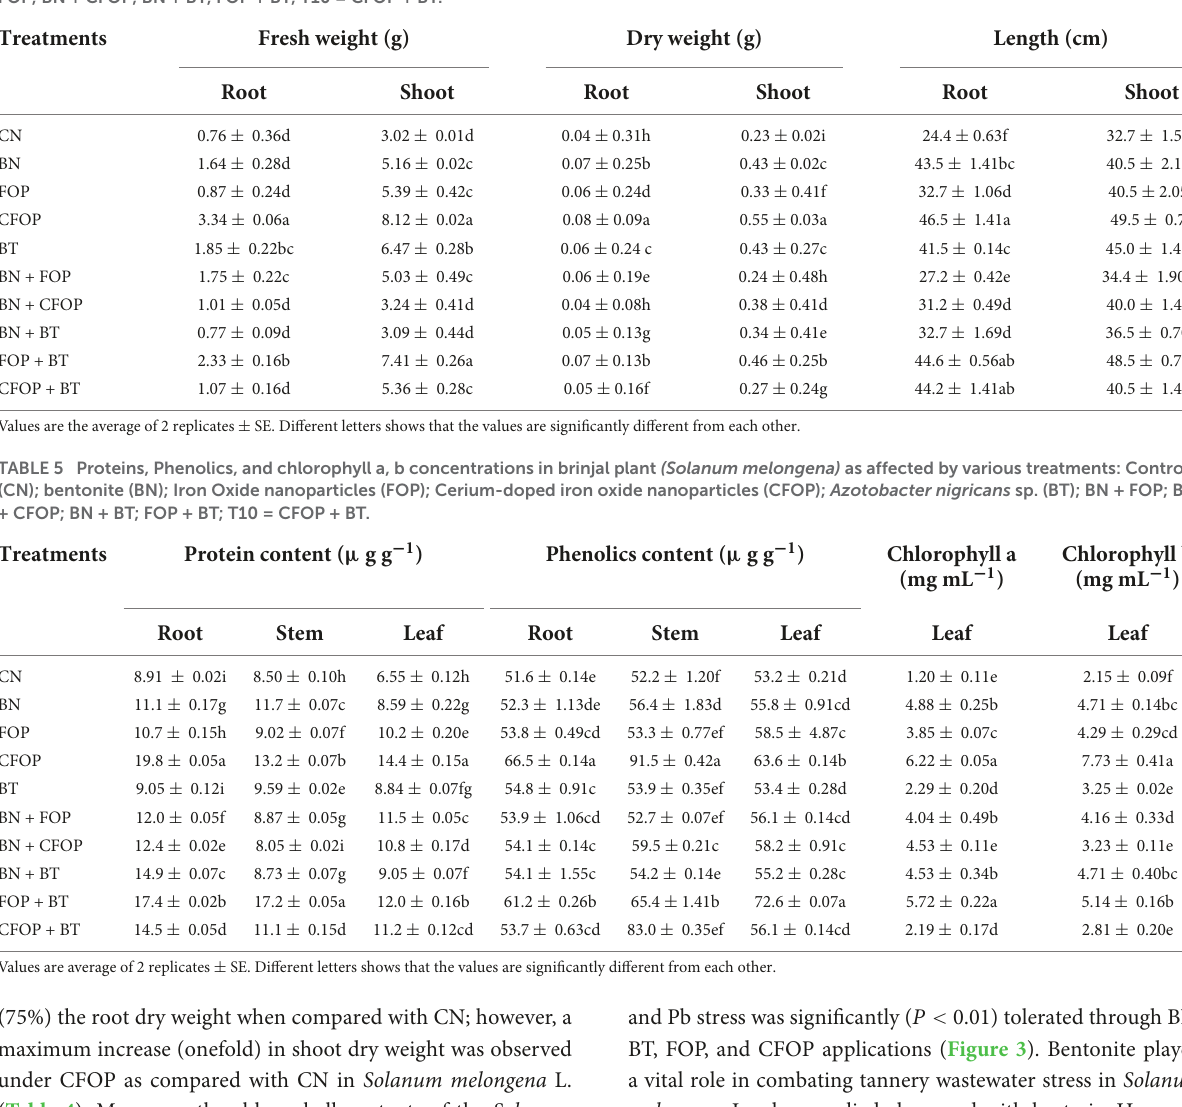
TABLE 4 Dry and fresh weight (g) and length (cm) of root and shoot of brinjal plant (Solanum melongena) as affected by various treatments: Control (CN); bentonite (BN); Iron Oxide nanoparticles (FOP); Cerium-doped iron oxide nanoparticles (CFOP); Azotobacter nigricans sp. (BT); BN